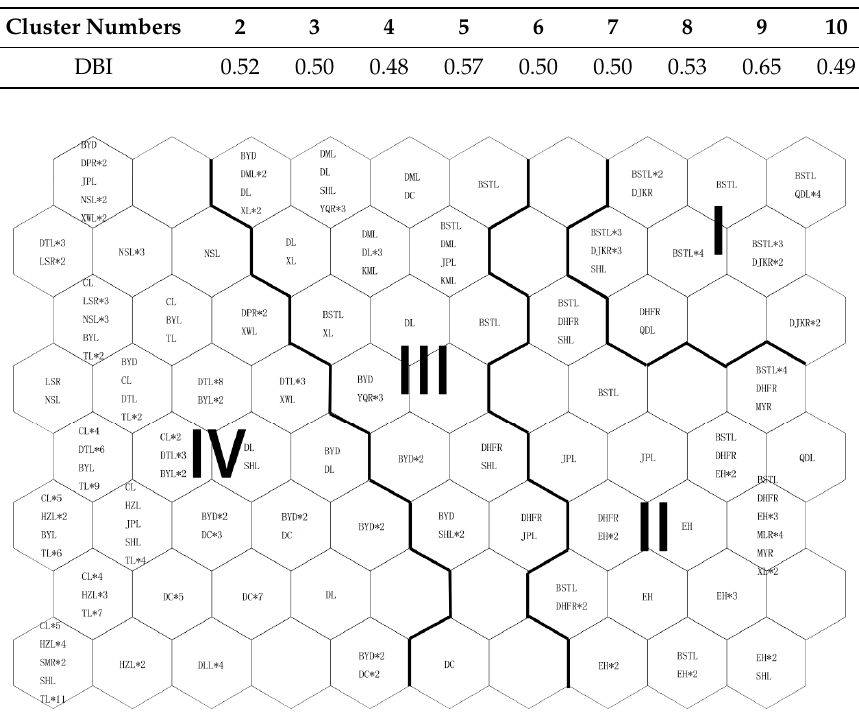
Figure 3. The clustering results of the trained SOM neurons. The k-means method was applied to define boundaries (dark lines) of the four clusters (I–IV) on the map.